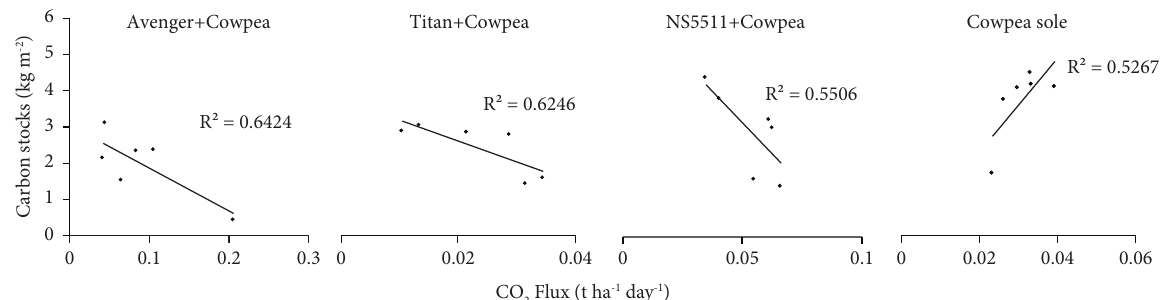
Figure 17: Carbon stocks ( y -axis) versus CO 2 emission rates ( x -axis) of sorghum and cowpea in binary and sole cultures at Syferkuil during the 2020/21 cropping